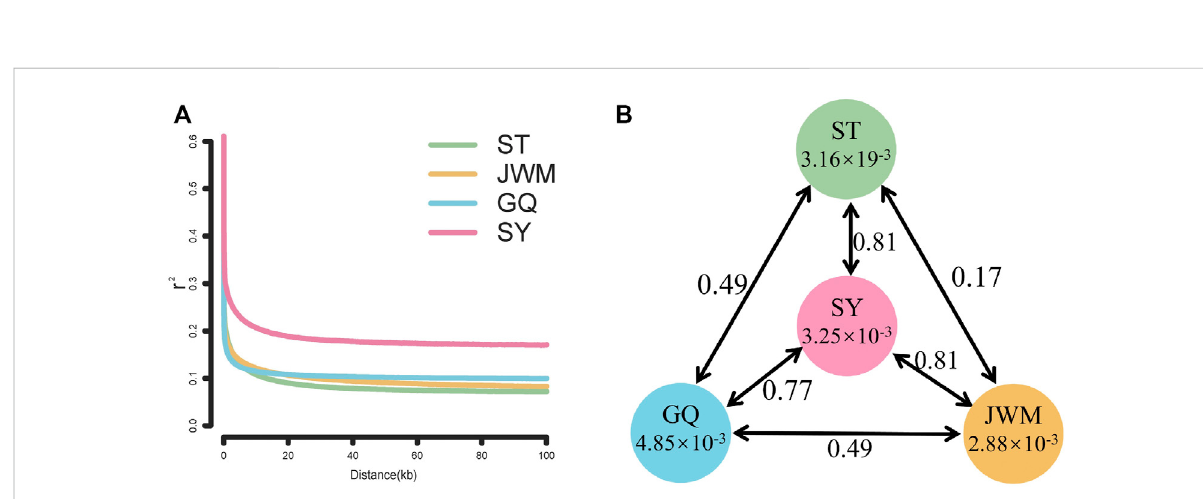
FIGURE 6 (A) Linkage disequilibrium patterns of four populations. (B) F ST values among populations and θπ in each